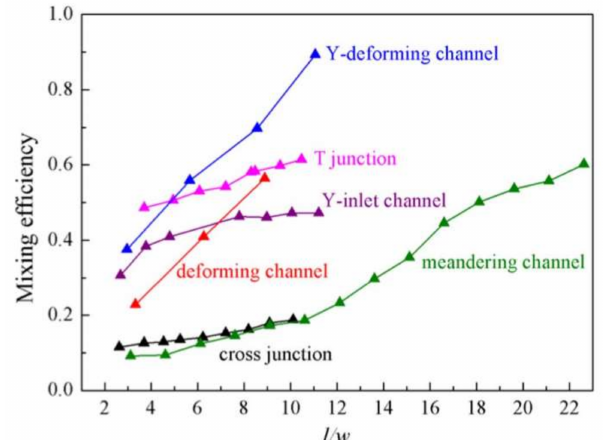
Figure 5. Mixing efficiency comparison in different micro-channels, reprinted with permission from [67].